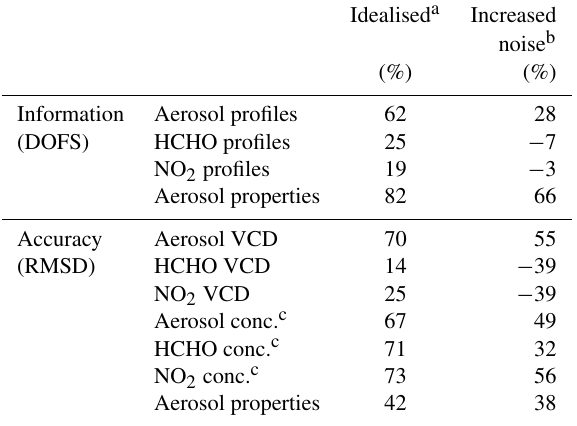
a Identical measurement noise for non-polarimetric and polarimetric observations. b Increased noise for polarimetric observations. c Values refer to the concentrations in the surface